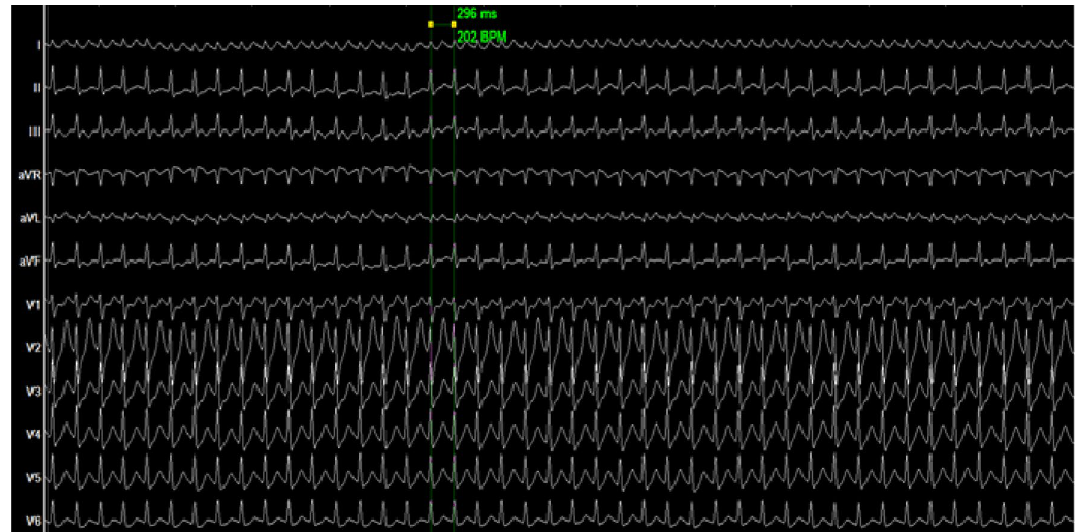
Fig. 2: 12-lead surface electrocardiogram showed a stable supraventricular tachycardia (cycle length: 296 ms) induced by atrial stimulation under isoproterenol perfusion during electrophysiology study